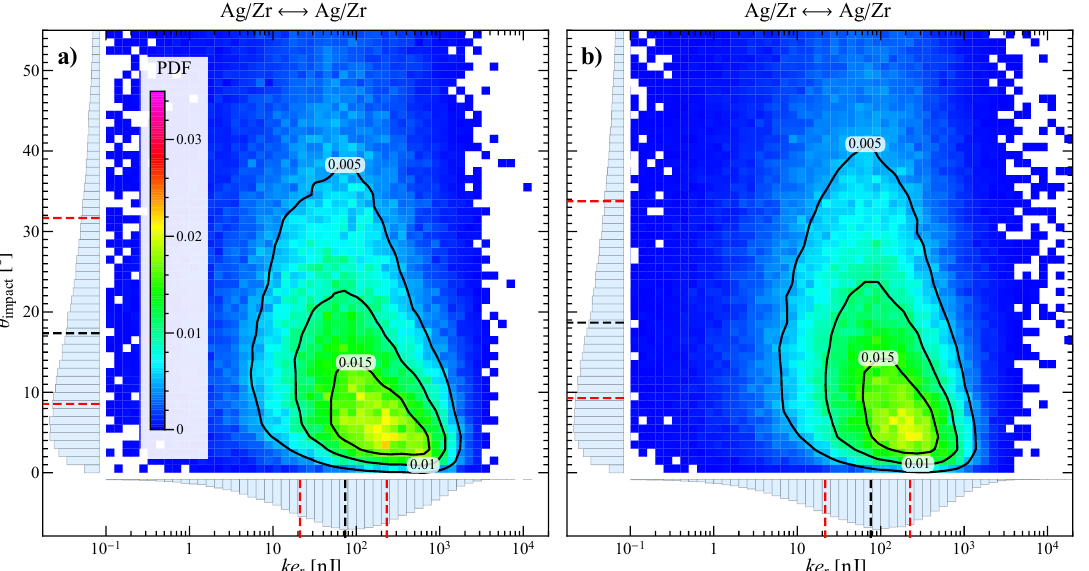
Figure 6. Map and contours of the joint probability density function for impact angle and relative kinetic energy for the impacts between all the particles at 600rpm and with stirring bar angle of ( a ) 30° and ( b ) 50°. On the edges of every map the marginal probability density functions and the corresponding quartiles are also shown (the dashed red lines representing the first and third quartiles and the dashed black line the